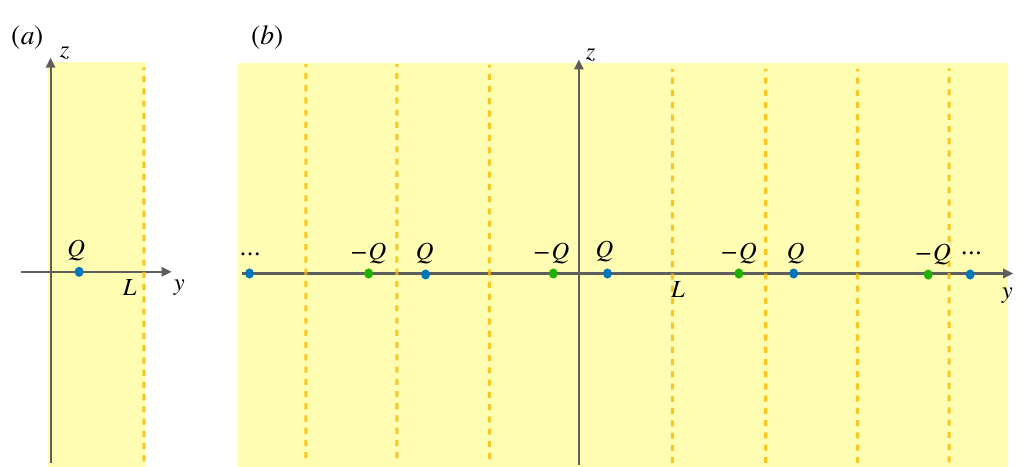
Figure 3: Panel (a) : Problem of a charge Q in a strip of dielectric material between two conducting lines at y = 0, L . Panel (b) : Position and values of the image charges that give the correct electrostatic potential inside the strip. This is the electrostatic analog of a massive quench problem, where the propagator plays the role of the electrostatic potential (see discussion in the text). To be compared with Fig.